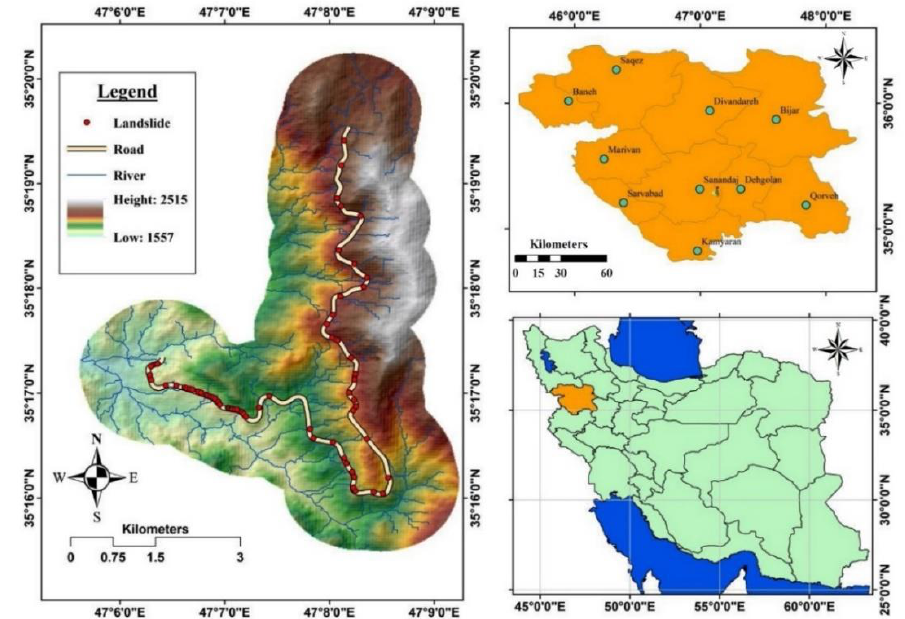
Figure 1. The study area and its location in Kurdistan province (upper right) in northwest Iran (lower right).